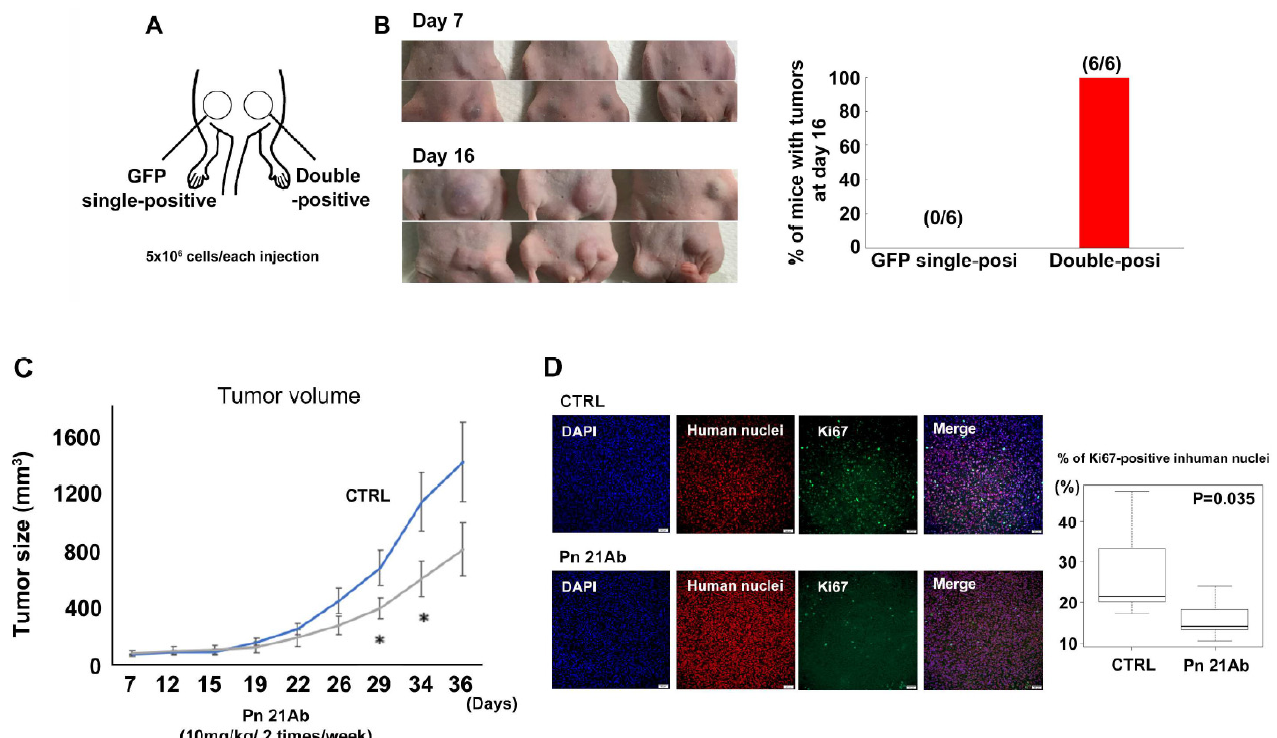
Figure 3. Pn ASV-specific antibody (Pn-21 Ab) inhibited the growth of double-positive SUM 159PT xenografts. ( A ) In total, 5 × 10 6 cells from SUM159PT GFP- and double-positive cells were separately injected into the abdominal mammary glands of athymic nude mice. ( B ) Images of tumor development at day 7 and 16 post injection. While GFP-positive cells did not form tumors (0/6), double-positive cells engrafted and developed tumors (6/6). ( C ) Athymic nude mice bearing SUM159PT double-positive cell tumors were treated with Pn-21 Ab or vehicle ( n = 7 for Pn-21 Ab, n = 6 for CTRL). The vehicle group received saline, and the other group was treated with Pn-21 Ab (10 mg/kg) 2 times per week throughout the experiments starting at day 0. Tumor volumes were recorded as mean ± SD. * p < 0.05. ( D ) Pn-21 Ab reduced proliferation in SUM159PT double-positive cell xenografts. Paraffin-embedded tumor sections from the CTRL and Pn-21 Ab groups were stained with antibodies against Ki67 and human nuclei. Ki67-positive human nuclei were quantified. Representative photomicrographs are presented, and quantitative data of Ki67-positive human nuclei are shown in box plots. The p value was calculated using the Mann–Whitney U test. Scale bars represent 50 µ